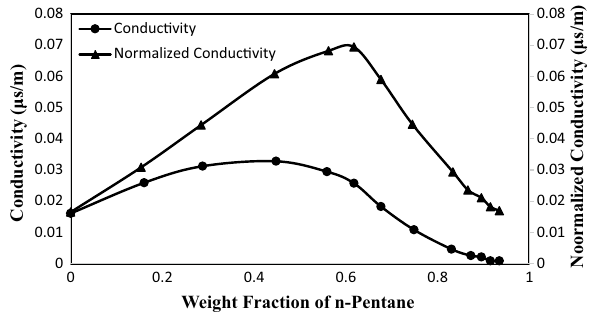
Fig. 23 Conductivity and normalized conductivity for crude B-pre- cipitant mixture (Fotland et al. 1993)